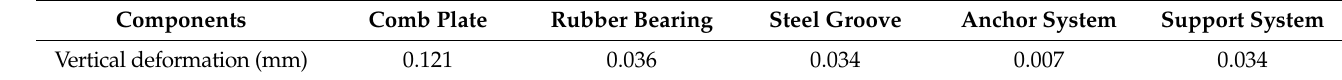
Figure 9. Vertical deformation diagram of the structure under the working condition I. Table 3. Results of deformation of the structure under the working condition I.